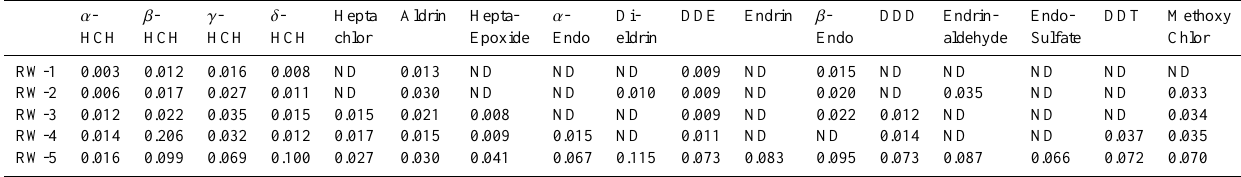
Table 6. Organochlorine residues ( µ gl − 1 ) in ground water (Ranny well) of Palla area during pre-monsoon seasons. α - β - γ - δ - Hepta Aldrin